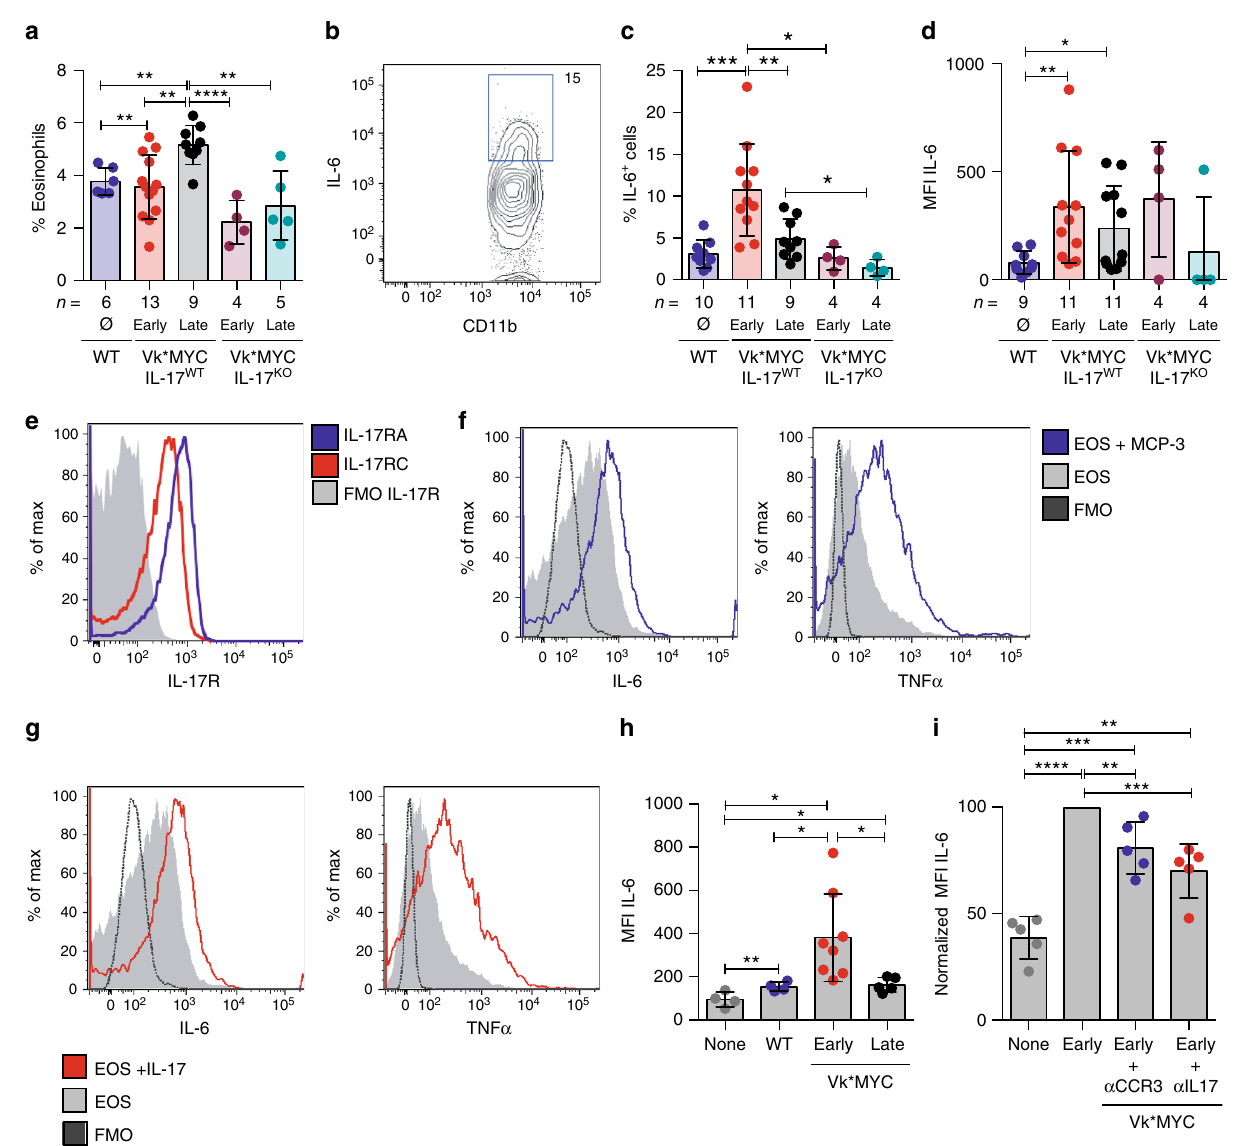
Fig. 5 An IL-17-eosinophil axis in the BM of Vk*MYC mice favors disease progression. a Frequency of BM eosinophils (i.e., CD11b + Ly6C int MHC-II − Ly6G − SSC hi or CD11b + Siglec-F + cells) in Vk*MYC IL-17 WT and Vk*MYC IL-17 KO mice and age- and sex-matched WT littermates. Each dot represents